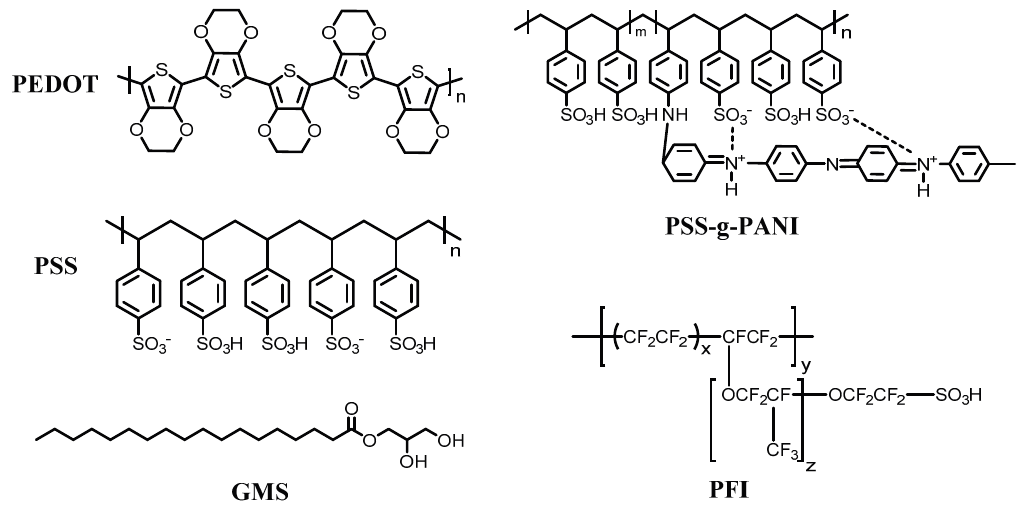
Figure 2. Chemical structure of poly(3,4-ethylenedioxythiophene) (PEDOT), poly (styrenesulfonic acid) (PSS), GMS (glycerol monostearate), poly(4-styrenesulfonate)- g -polyaniline (PSS- g -PANI), and PFI (perfluorinated ionomer) for interfacial layer materials in polymer solar